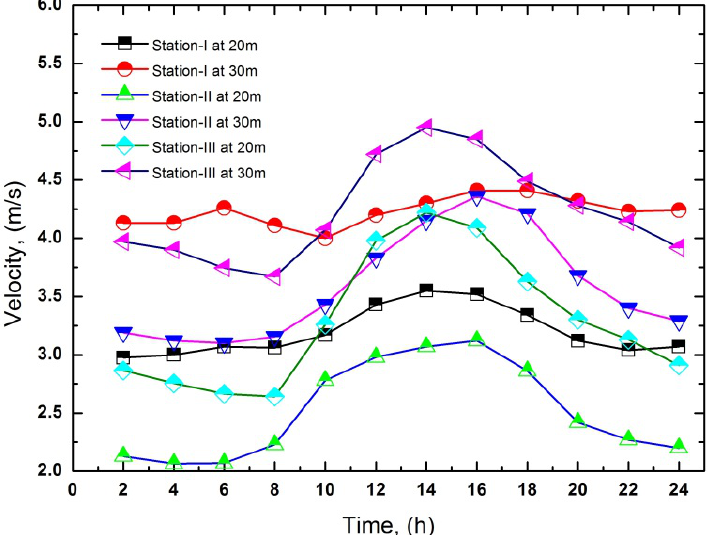
Figure 1. Hourly mean wind speed at 20 m and 30 m height for the selected